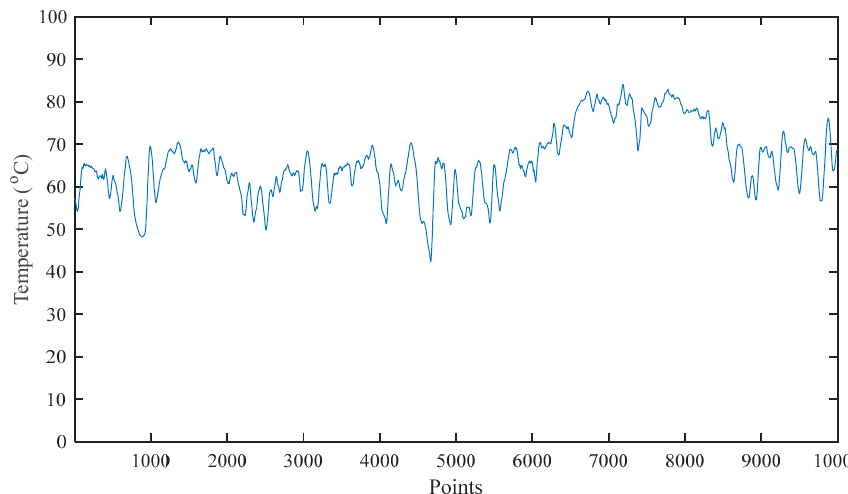
Figure 15. Actual temperature of the gearbox bearing gained from the SCADA data (Case 2).